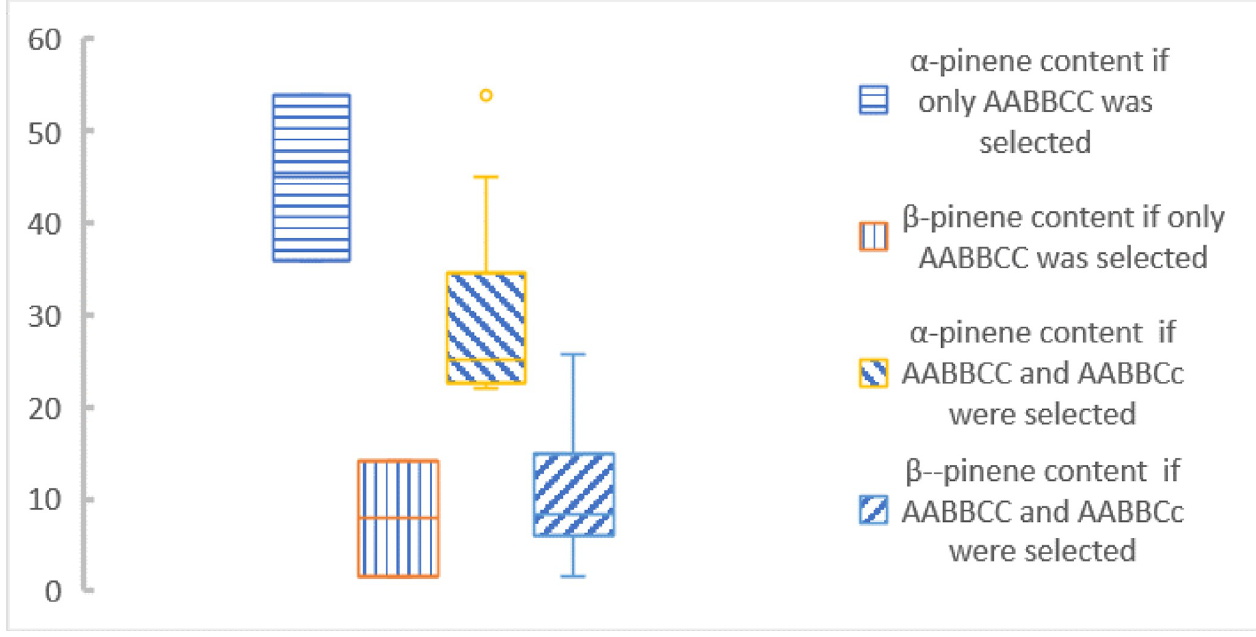
Fig 9. Box map of α -pinene and β -pinene content in two different selection methods.